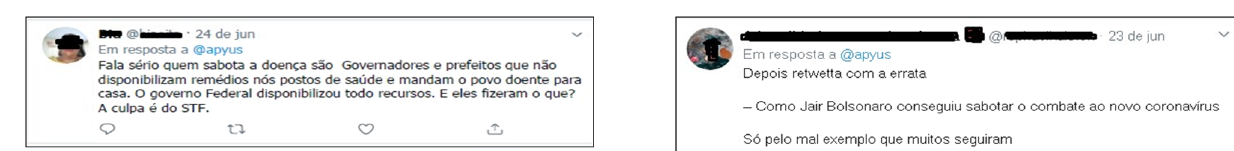
Fig. 5 A Bolsonararian co-framer sustains the position that Bolsonaro ’ s actions are not acts of sabotage. Translation : Get real! [Those] who sabotage [sic] the disease are the governors and mayors, who have not supplied medicine to the medical facilities and send ill people back home. The Federal government made all the resources available. And what have they done? It ’ s the Federal Supreme Court ’ s fault.